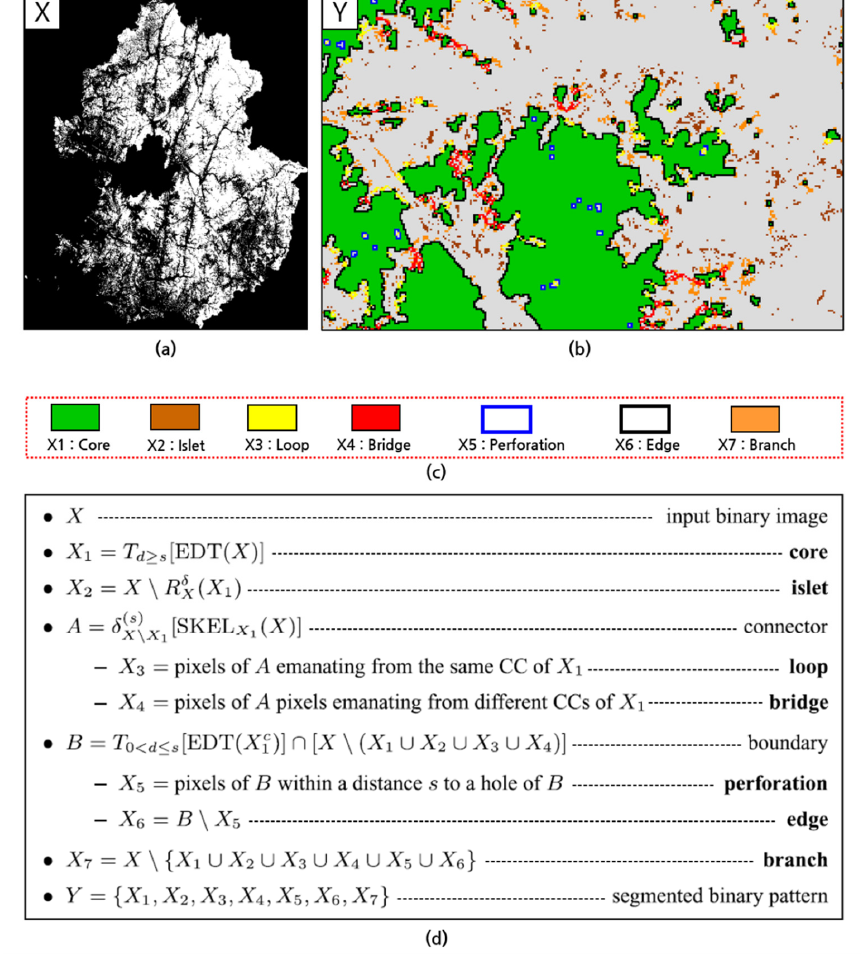
Figure 4. ( a ) Input binary image of research cities, ( b ) segmented binary pattern, ( c ) seven categories of MSPA and ( d ) equation for each step [40].